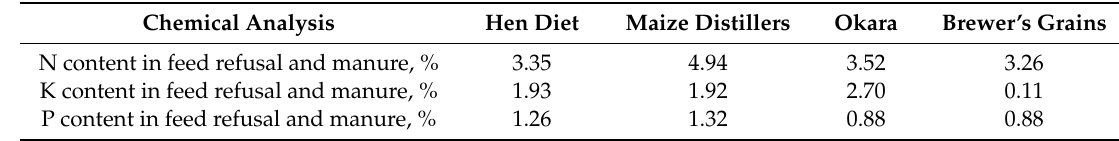
Table 5. Chemical analysis of feed refusal and